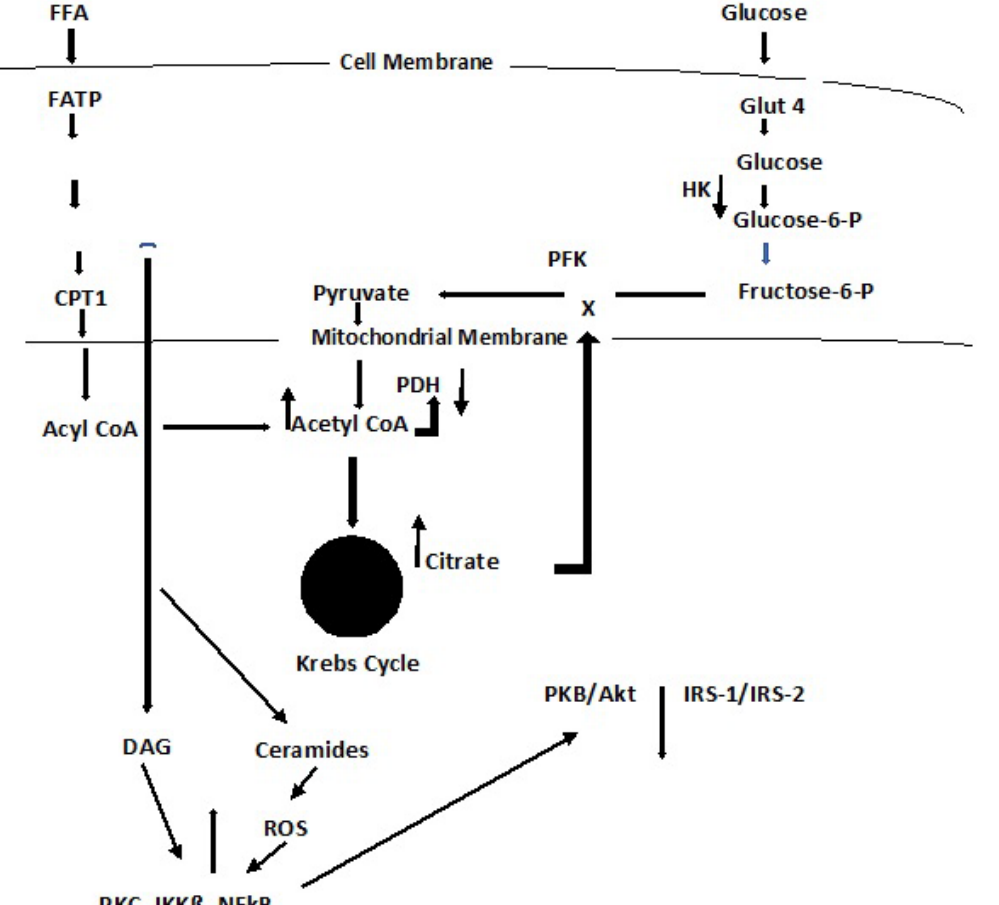
Figure 8. Lipid Oxidation and Cell Signaling [52]. FFA, free fatty acid; FATP, free fatty acid transport protein; FACS, free fatty acid acyl-CoA synthase; CPT1, carnitine palmitoyl transferase 1; DAG, diacylglycerol (refer to Figure 5); PDH, pyruvate dehydrogenase; PFK, phosphofructokinase; HK, hexokinase; GLUT 4, glucose transporter 4; PKC, protein kinase C; IKKß, inhibitory kß kinase ß; NFkß, nuclear factor kß; P13K, phosphoinositide 3-kinase; PkB/Akt, protein kinase B; IRS-1/IRS-2, Insulin receptor substrate 1 and 2.